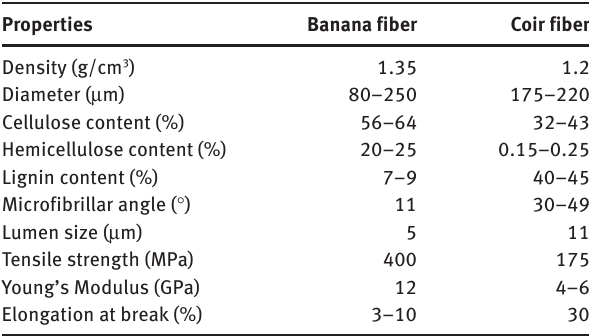
Table 1: Physical properties of banana and coir